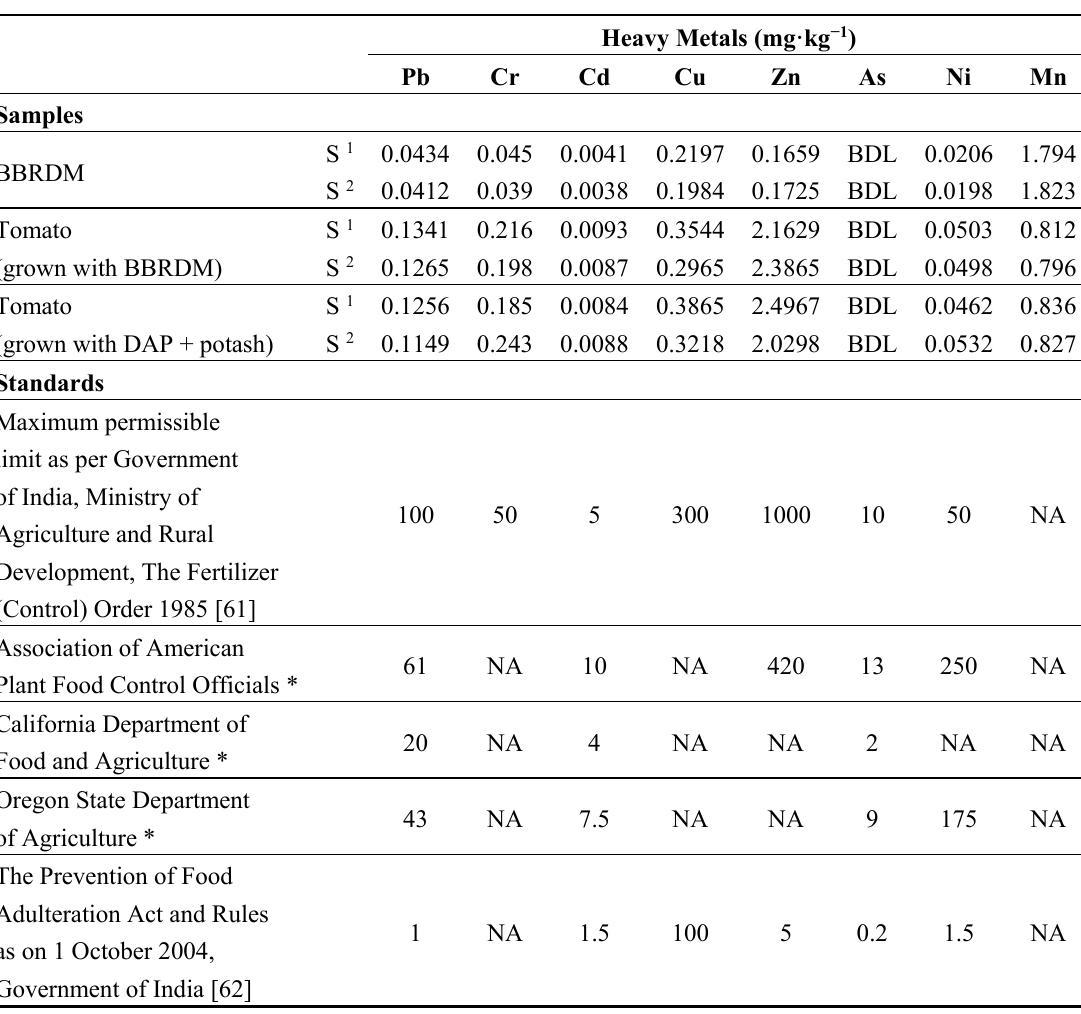
Table 2. Heavy metal content of BBRDM (fertilizer) and tomatoes (grown with BBRDM and DAP + potash). Ten fresh tomatoes grown with BBRDM and an equal number cultivated with DAP + potash obtained at the end of the harvest (by combining all five harvests) were considered for this test. Determination was done thrice in duplicate sets ( n = 6) for each harvest ( a ). Indian and international standards for heavy metal content in fertilizer and food ( b